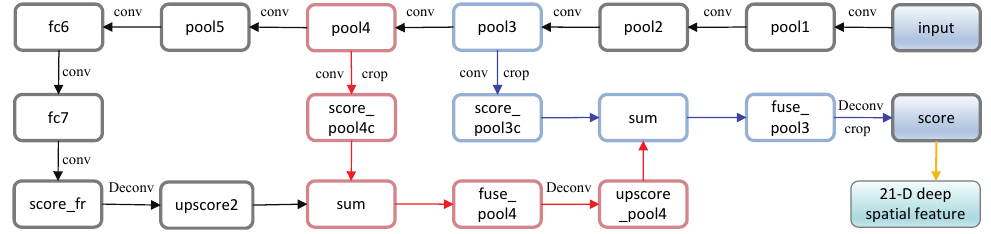
Figure 6. The procedure of extracting deep multi-scale spatial features via FCN-8s: “conv”, “Deconv” and “crop” denote convolutional operation, deconvolutional operation and crop operation, respectively. The 21D outputs of “score” layer are the desired deep spatial features.